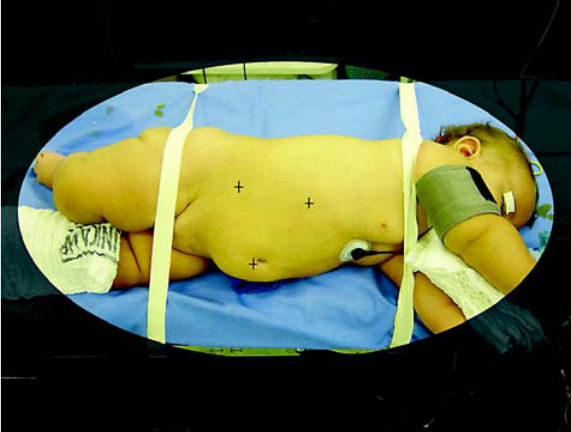
Figure 1 – Photographic representation of a patient in lateral decubitus showing the location of the